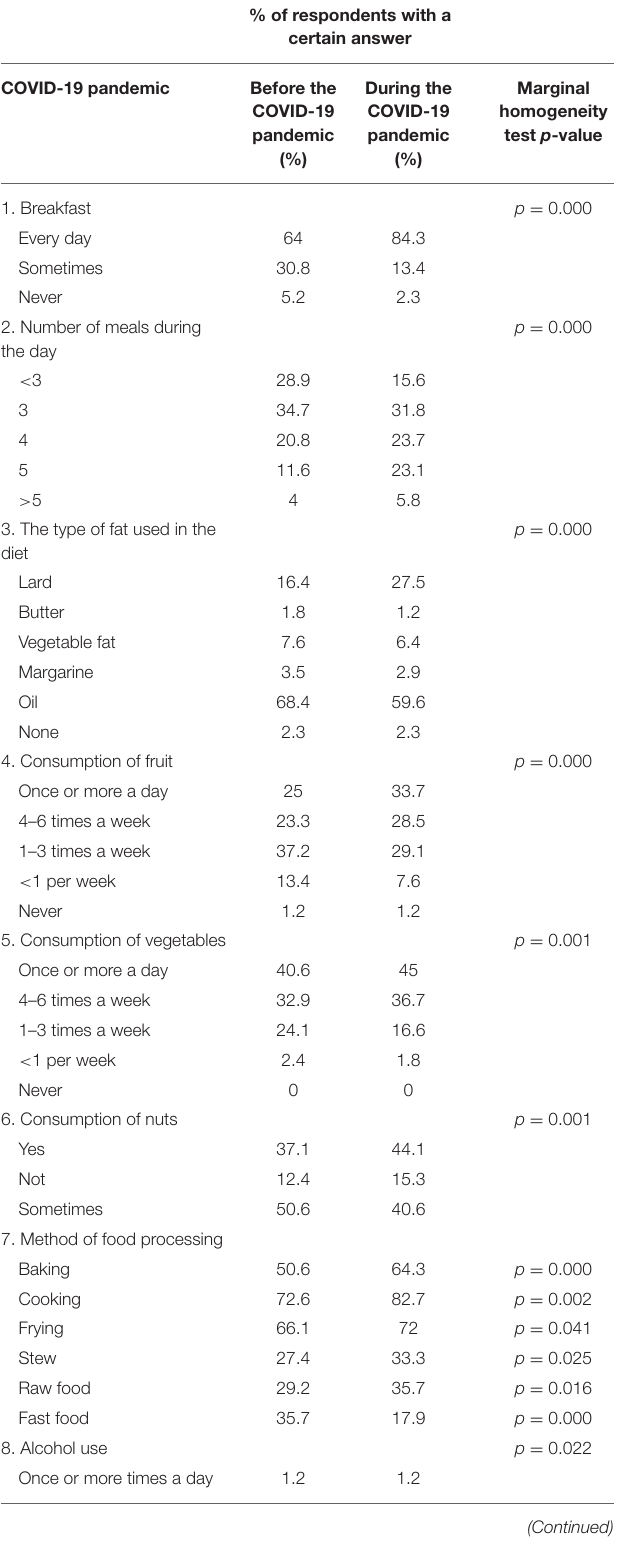
TABLE 3 | Overview of the percentage of respondents’ responses regarding eating habits and supplementation in which a significant difference was found before and during the COVID-19 pandemic (Marginal homogeneity